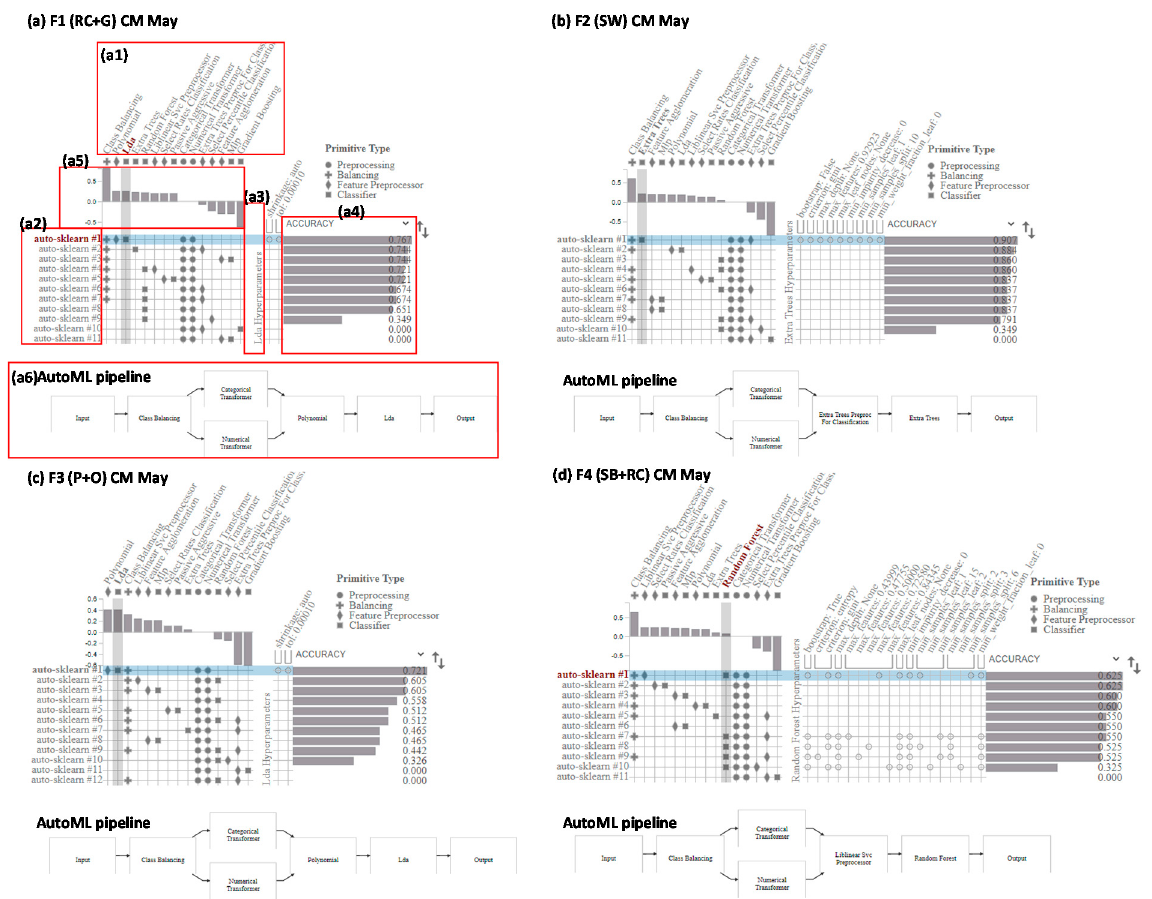
Figure 7. The interactive AutoML pipeline matrix plots with running time-limited setting 60 s sorted by accuracy performance ( a – d ), ( a ) Field 1 pipeline matrix with the Top1 classifier LDA, where ( a1 ) illustrated Primitives (in columns) used by the pipelines ( a2 ) (in rows, the blue line showed the best accuracy rank); ( a3 ) one-hot-encoded hyperparameters (in columns) for the primitive across pipelines, ( a4 ) the AutoML pipeline with the accuracy ranking; ( a5 ) Primitive contribution view, showing the correlations between primitive usage and pipeline scores—in a5 displays that class balancing has the highest correlation score with accuracy; ( a6 ) Step by step AutoML Pipeline flowchart. The ML box before Output represents the classifier used by this set of algorithms (in a6 LDA as the classifier) ( b – d ) Fields 2, 3, and 4 interactive pipeline matrix sort by AutoML accuracy performance with the chosen hyperparameters (top 1 was